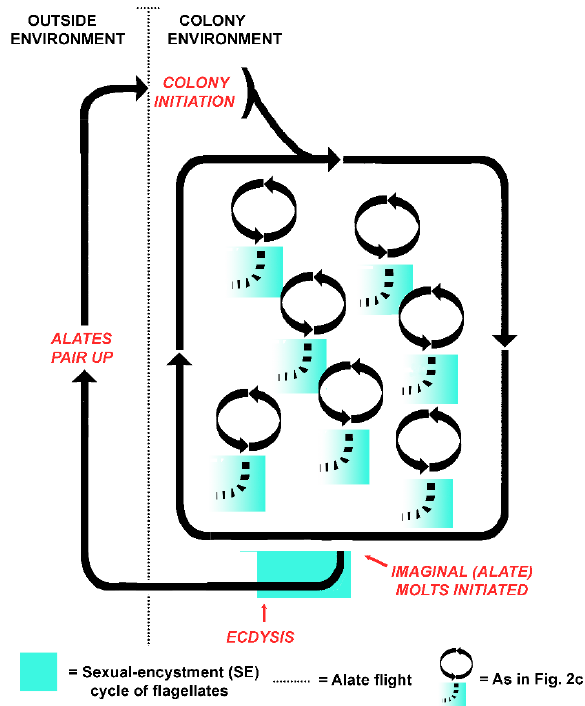
Figure 4. Coordination of the life cycle of a termite colony with the sexual/encystment (SE) cycle of the gut flagellates of individual colony members. During typical molts of colony members, the flagellates exhibit aborted SE cycles and die. During the imaginal molt to the alate stage, the flagellates undergo a functional SE cycle in concert with the reproductive maturation of the termites.